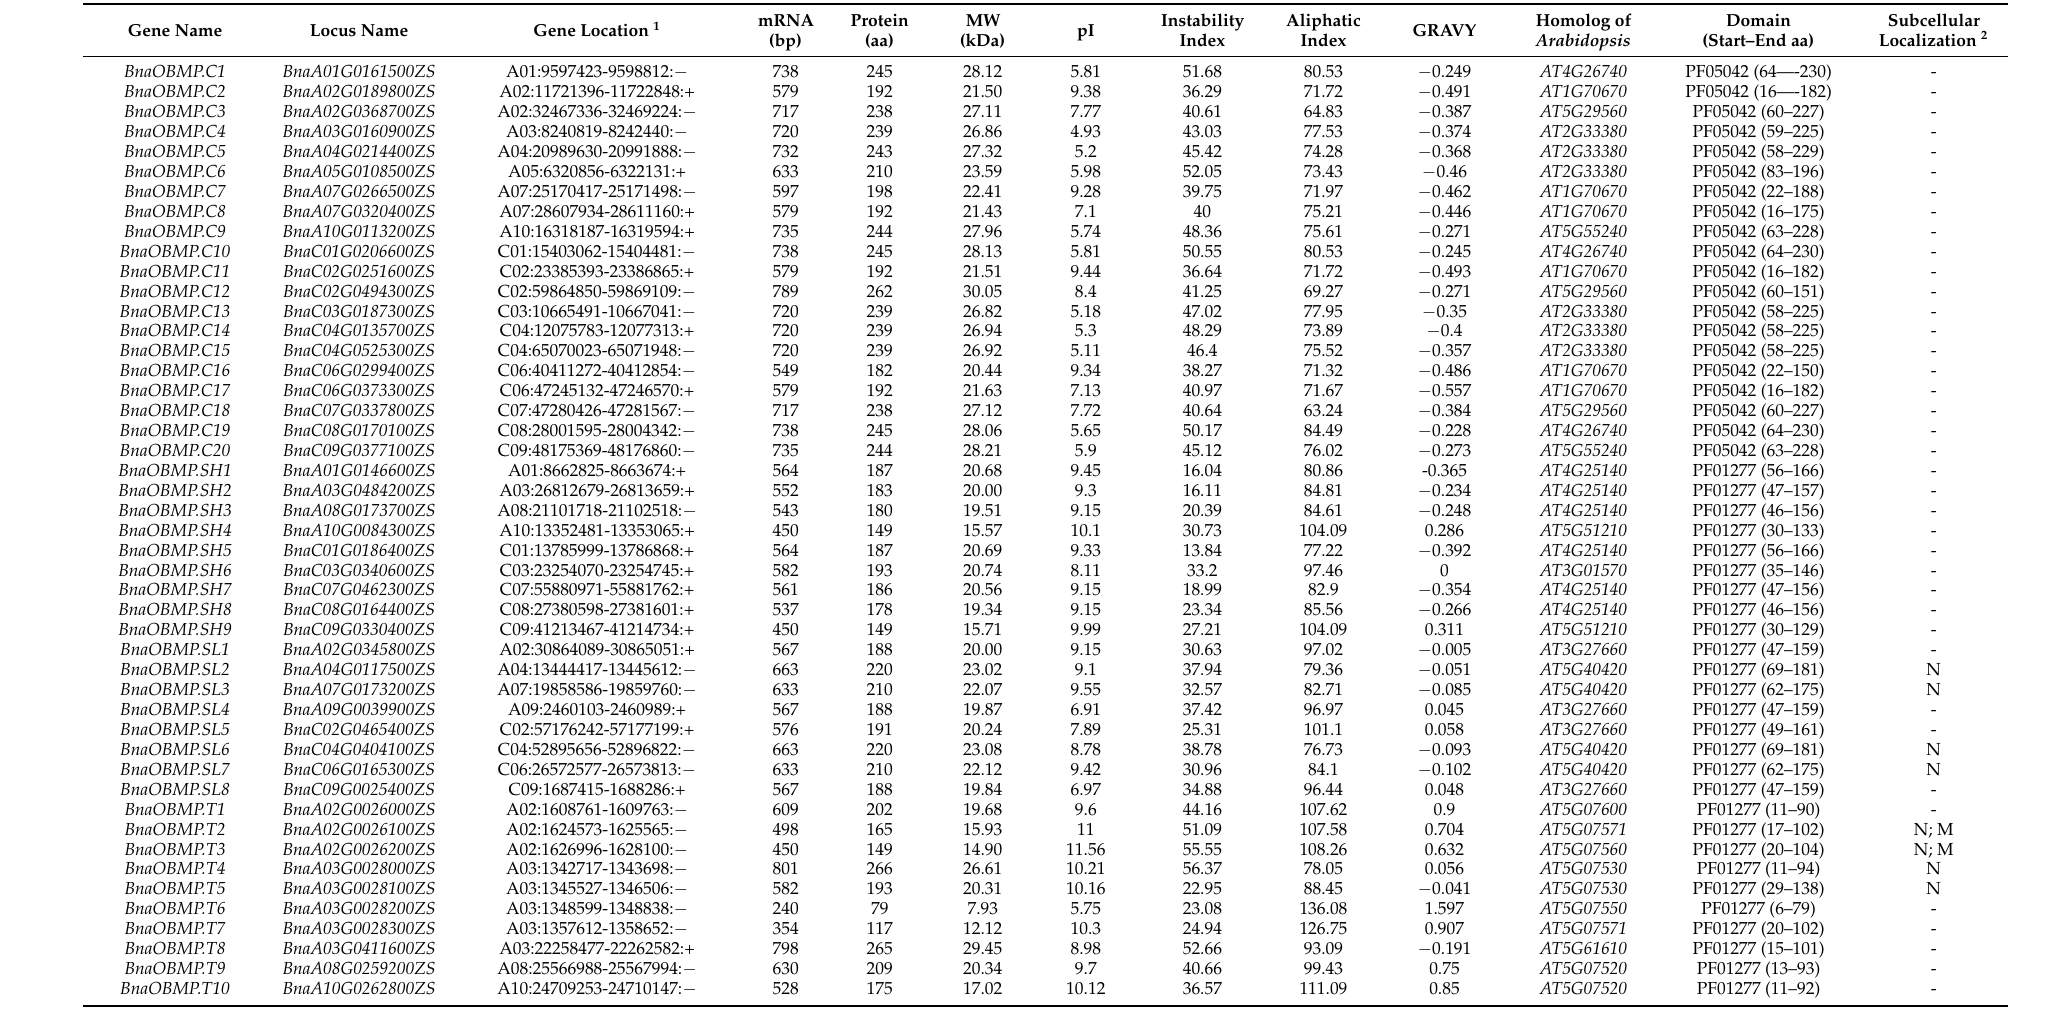
Table 1. Summary information on OBMP family genes in B. napus